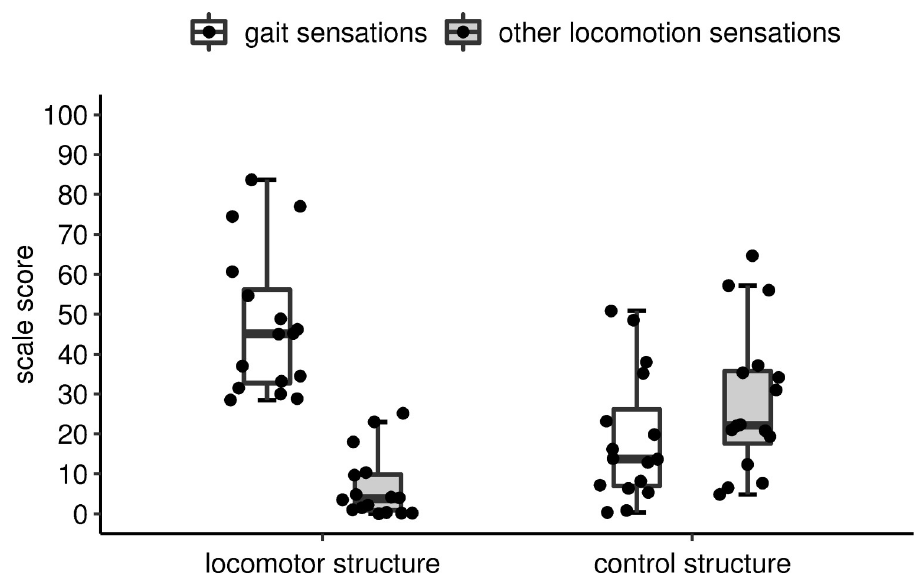
Fig 2. Comparison of gait sensations and other locomotion sensations. Box-and-whisker plots of the scores for gait sensations and for other locomotion sensations in the locomotor structure trials and in the control structure trials. Bold horizontal lines indicate median overall rating score; boxes indicate the lower and upper quartiles; whiskers indicate the farthest data points within 1.5 times of the lower and upper quartiles, respectively. The circles depict the individual scale scores of the 16